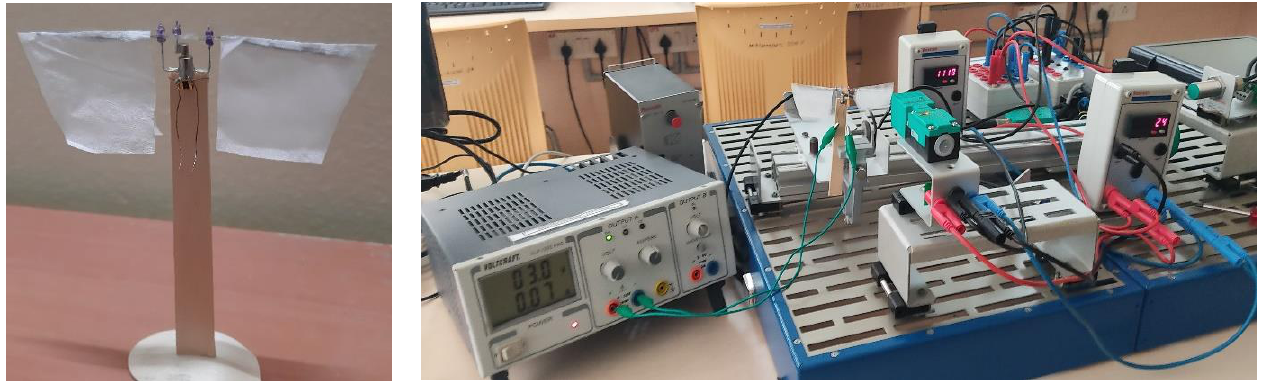
Figure 22 . SC-SDL design II with Flapping Frequency Measuring Setup. Figure 22. SC-SDL design II with Flapping Frequency Measuring